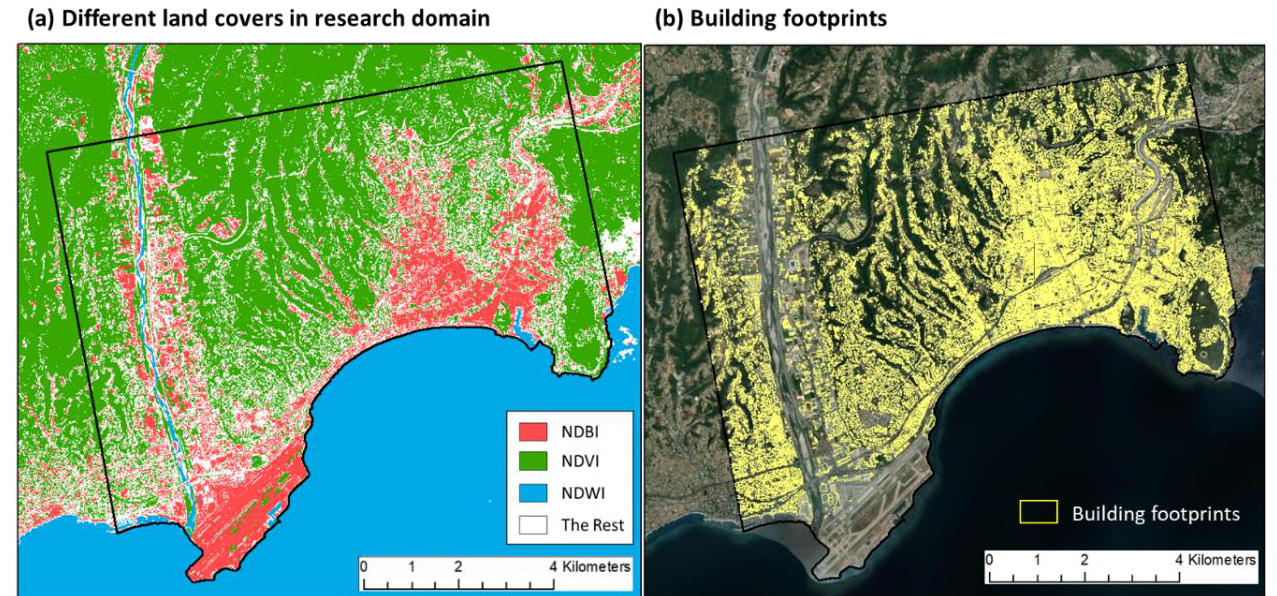
Figure 3. Different land covers derived from Sentinel-2 and the building footprint in Nice, France: ( a ) Different land covers, ( b ) Building footprints.